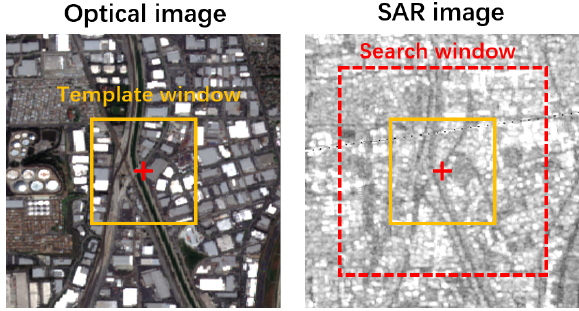
Figure 2. The process of the similarity